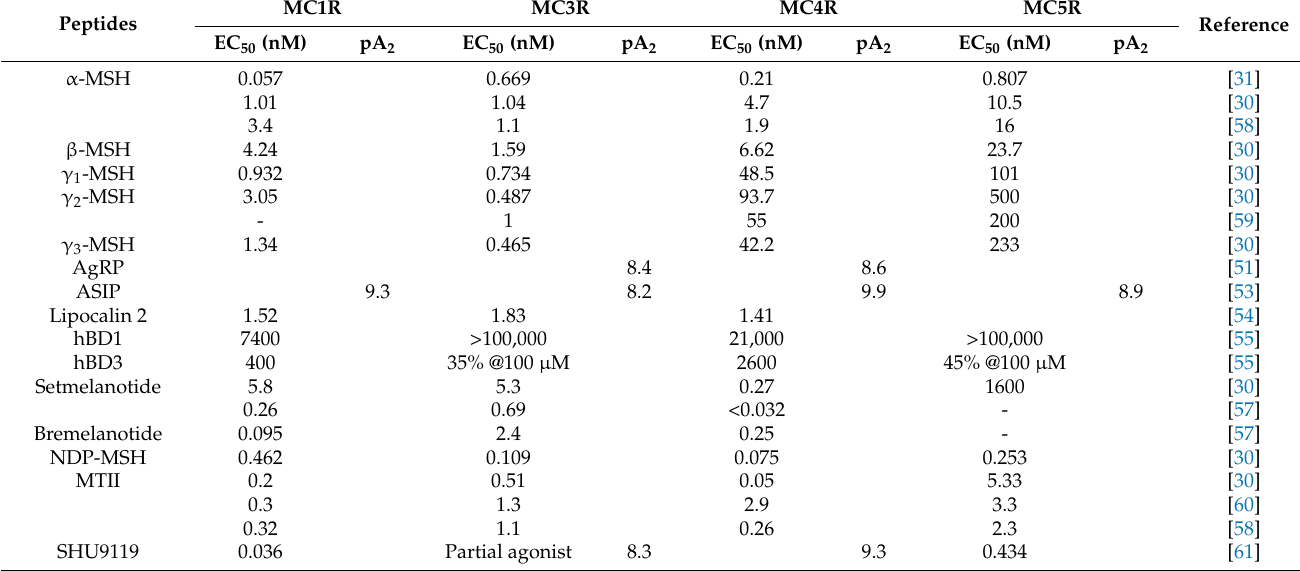
Table 3. Functional pharmacology of melanocortin ligands at human melanocortin